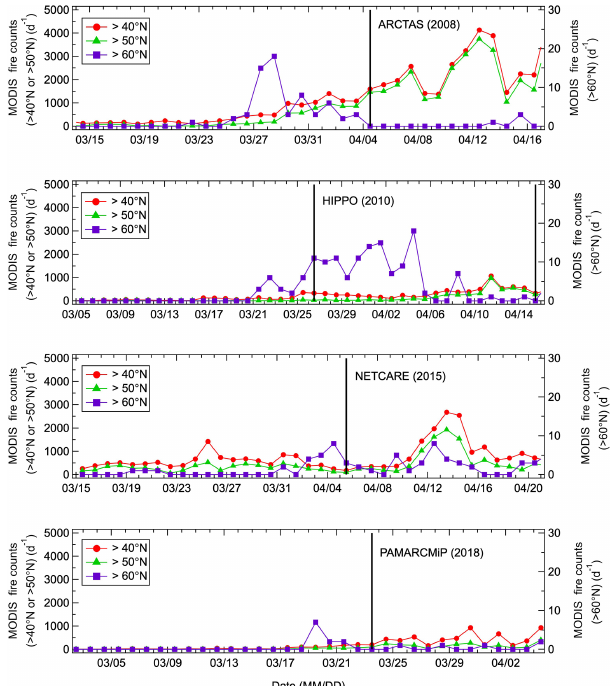
Figure C1. Time series of the daily averaged number of fire counts (countsd − 1 ) detected by the MODIS satellite. Vertical bars indicate the start dates of the individual aircraft-based experiments. Figure D1. Vertical profiles of median BC mass concentration ( M BC ) values observed during the aircraft-based experiments made over the Arctic ( > 66 . 5 ◦ N) in spring. Bars indicate 25%–75% ranges. Model-calculated vertical M BC profiles are derived by cal- culating area-weighted averages within the latitudes and longitudes and the time periods of the individual aircraft-based